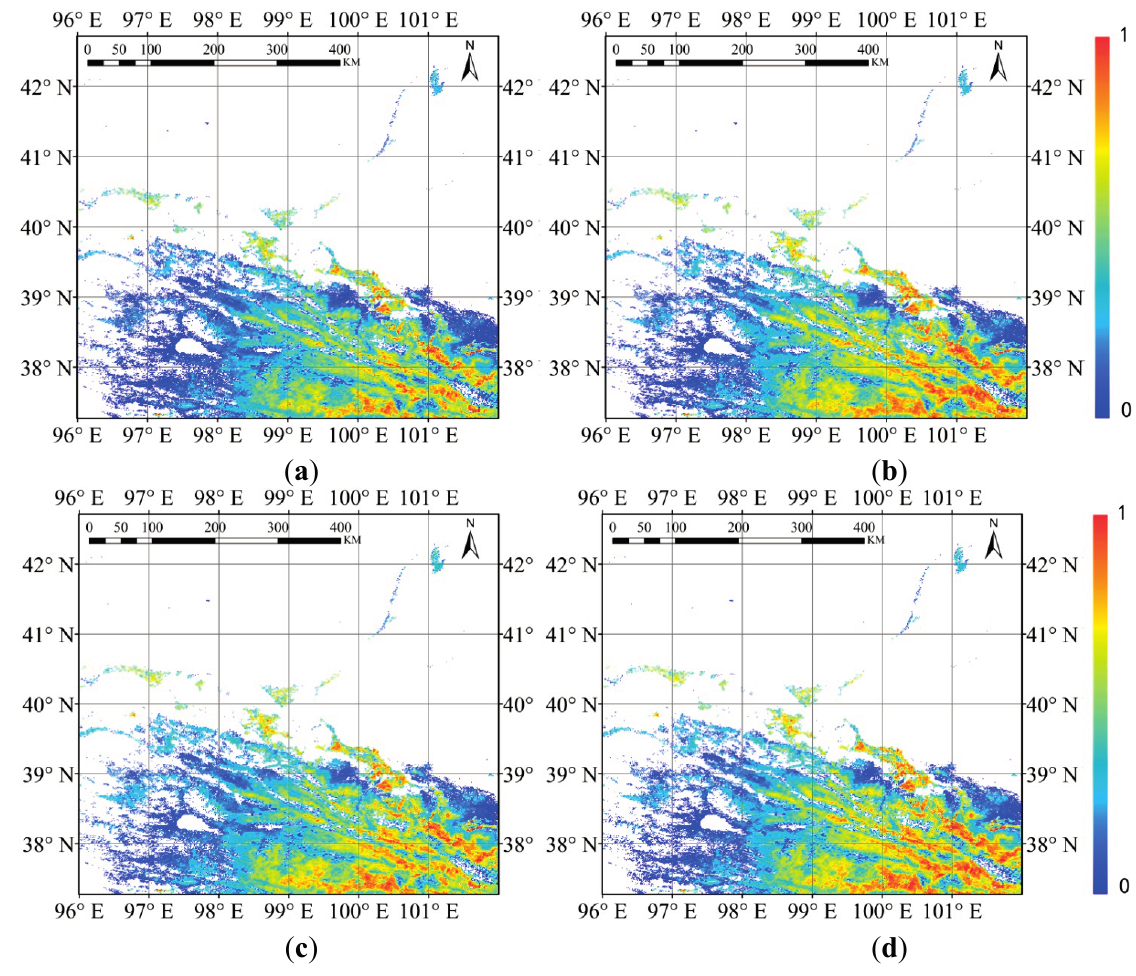
Figure 5. FPAR inversion: ( a ) direct FPAR at noon, 5 July 2012; ( b ) diffuse FPAR at noon, 5 July 2012; ( c ) total FPAR at noon, 5 July 2012; ( d ) daily average FPAR on 5 July